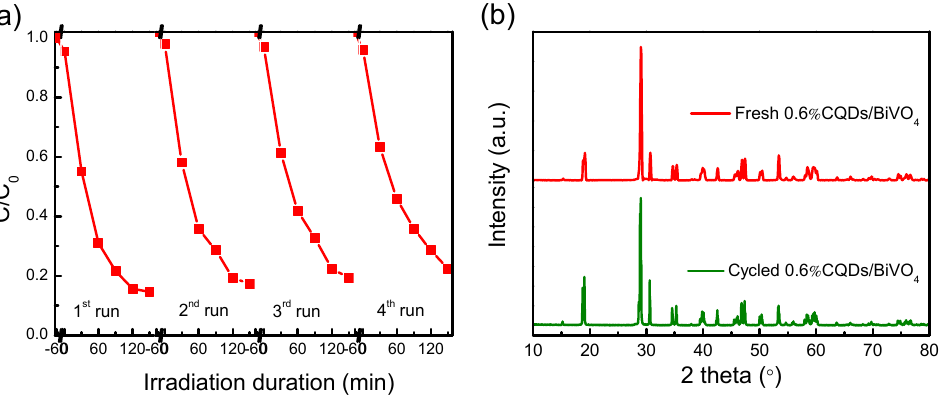
Figure 6. ( a ) Photocatalytic degradation of BzP over 0.6%CQDs/BiVO 4 composite in consecutive four cycles, and ( b ) XRD patterns of the used catalyst before and after the four cycles.